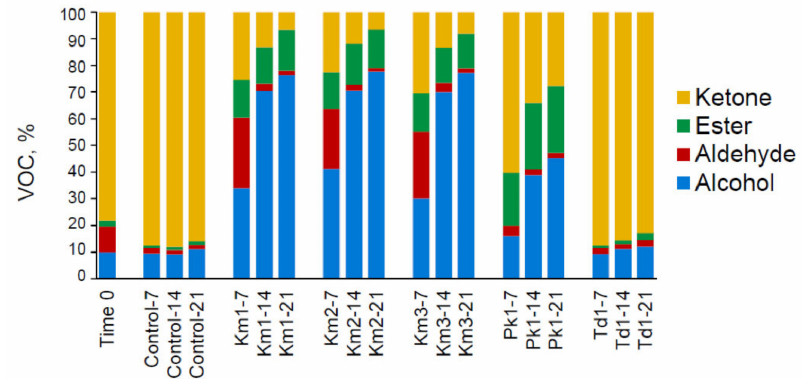
Figure 3. Distribution of the major types of volatile compounds (alcohols, aldehydes, esters and ketones) produced by yeasts K . marxianus (strains Km1, Km2 and Km3), P. kudriavzevii Pk1 and T. delbrueckii Td1 grown in skyr at 8 ◦ C for 21 days and in controls (skyr without yeasts). Sample codes denote the strain ID and the incubation period (0, 7, 14 and 21 days). Mean values from triplicate experiments are